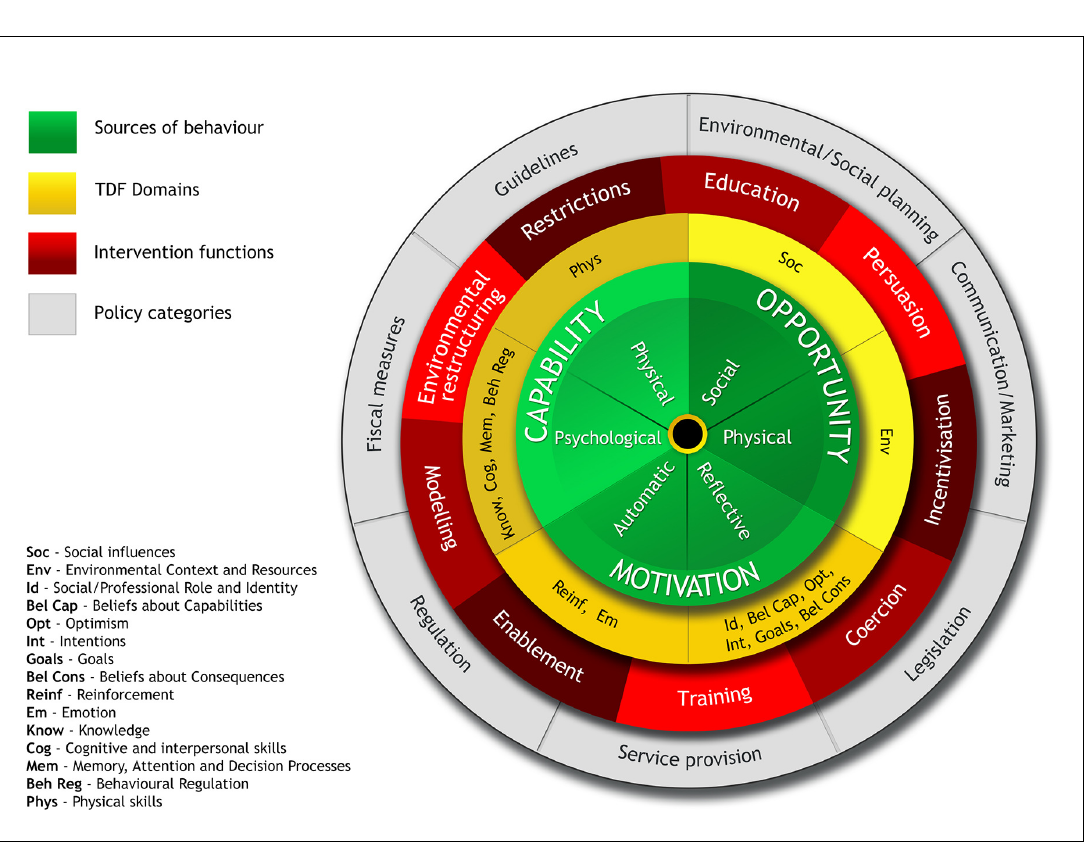
Figure 2. The behaviour change wheel, a framework for understanding behaviour (reproduced with permission from the authors) 44